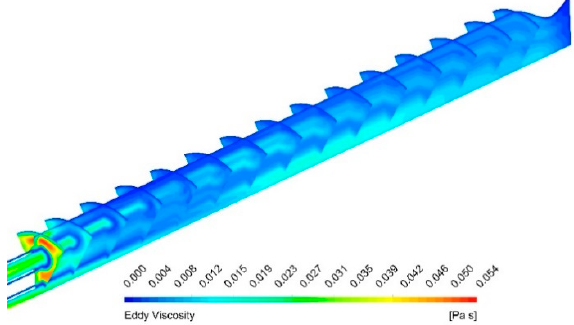
Figure 28. BSL EARSM model eddy viscosity distribution (50% axial scaling).